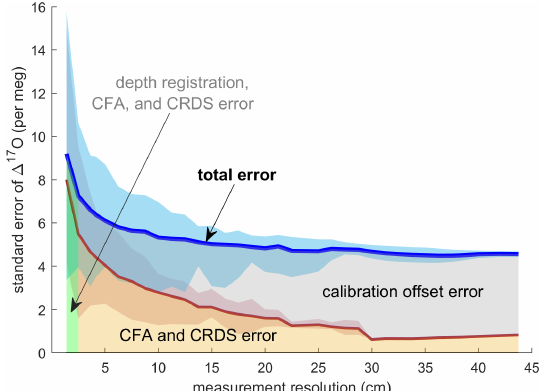
Figure 6. Standard error of all replicate CFA measurements as a function of measurement integration depth. The blue line shows the mean of the standard error of (cid:49) 17 O calibratedCFA as calculated for each depth interval; the shaded blue area indicates the minimum and maximum values of the standard error across all depth inter- vals. The red line and shaded area show the relationship between the standard error in (cid:49) 17 O adjustedCFA and the measurement resolu- tion. The area beneath the total error line is highlighted to indicate error